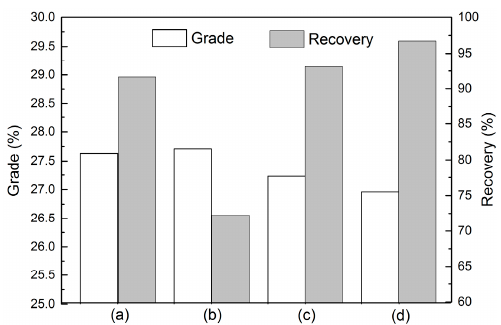
Figure 2. Grade and P 2 O 5 recovery of phosphate concentrates for sedimentary phosphate ore under different conditions ( a ) cottonseed oil soap, 25 °C, 1 kg/t; ( b ) sodium oleate, 25 °C, 1 kg/t; ( c ) sodium oleate, 25 °C, 2 kg/t; ( d ) sodium oleate, 40 °C, 1 kg/t.